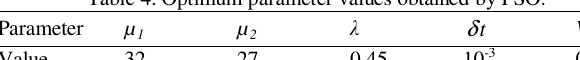
Table 4. Optimum parameter values obtained by